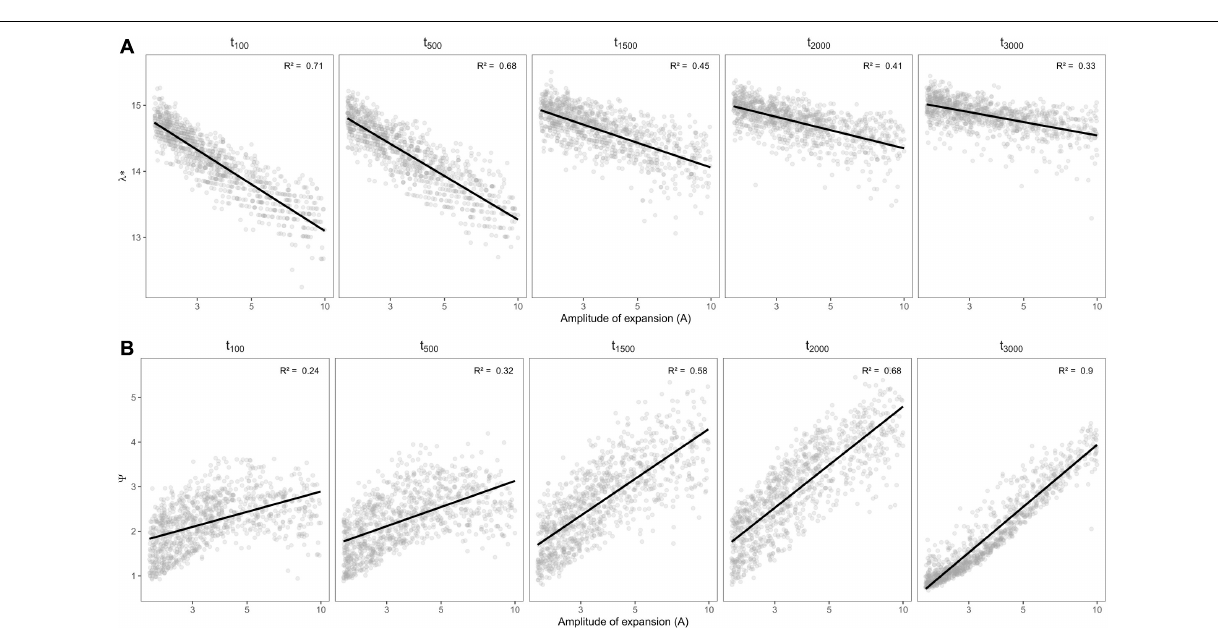
FIGURE 6 | Variation in spectral density profile summary statistics: (A) ln-transformed principal eigenvalue ( λ *) and (B) skewness ( ψ ), of rerooted phylogenies (vis a vis oldest simulated MRCA) depending on the amplitude of expansion and the time (in generations) at which it occurred. Linear regressions are shown in black with the associated R 2 statistic in the upper-left side of each